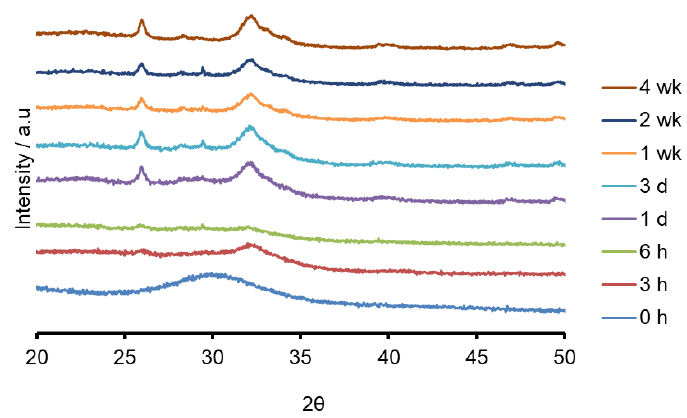
Figure 2. XRD patterns of K-FBAG before and after immersion.